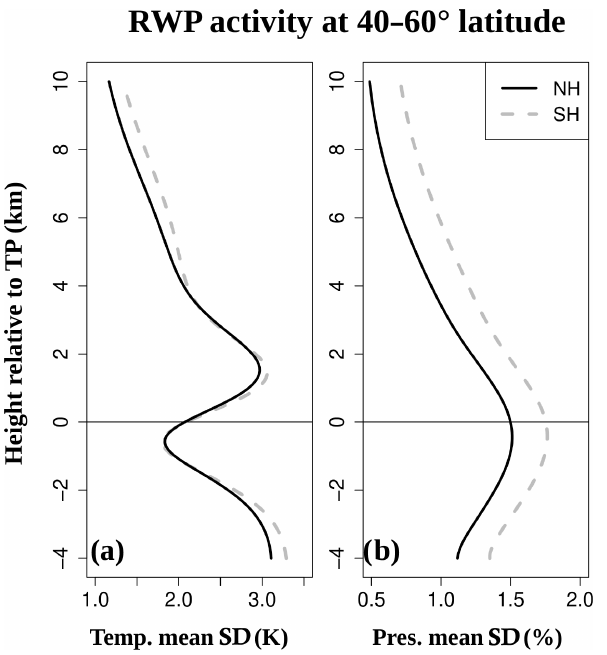
Figure 5. Vertical profiles of (a) temperature and (b) pressure time- mean RWP activity within 40–60 ◦ latitude, calculated as the mean standard deviation of w4–8 daily anomalies and relative to the zonal-mean tropopause height.